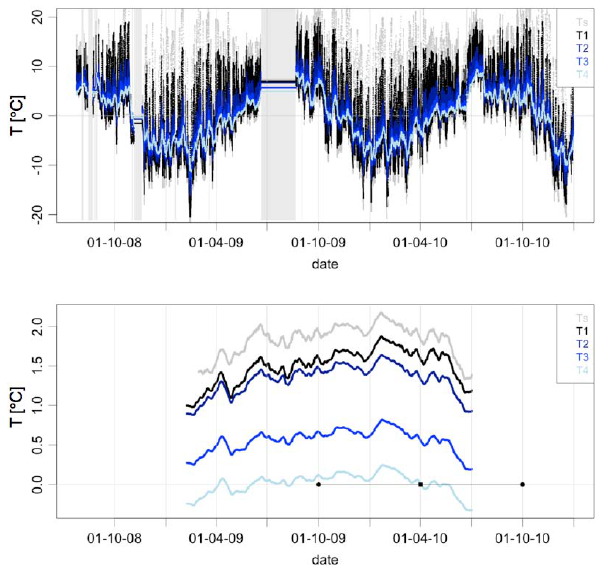
Fig. 7. Time series from July 2008 to the end of 2010 of the rock temperature measurements (top) at mh10 with interpolated values in data gaps (grey bars) and corresponding running annual means (bottom) that are represented in the center of the averaging window. The black dots indicate this averaging window for one MAT with the quad showing the point in time of its representation. For most sensors this averaging window was chosen to minimize data